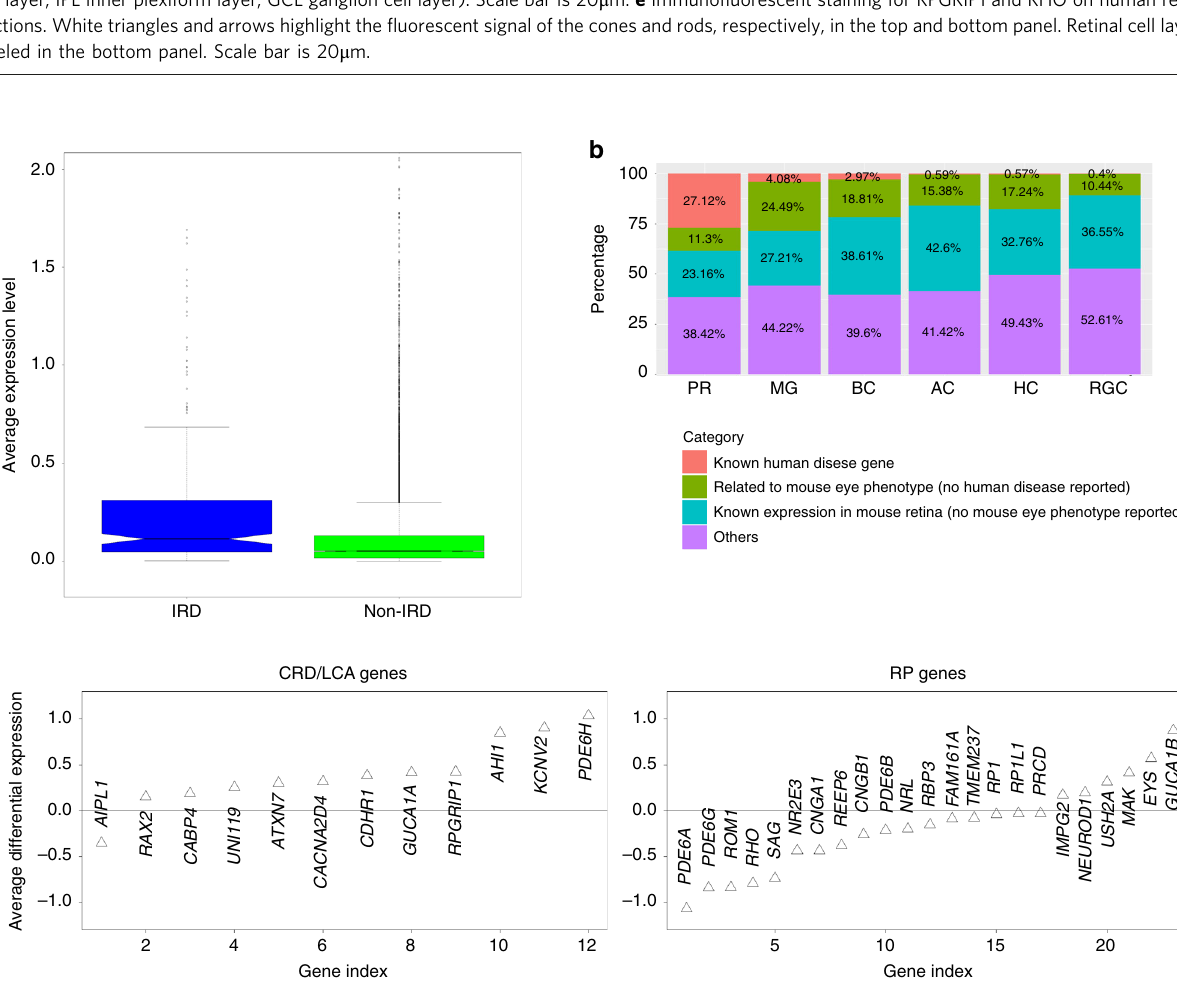
Fig. 5 Photoreceptor DEGs enrich human IRDs. a IRD genes generally show higher expression level than the rest of genes in the human retina. Expression values for each gene were normalized by cell total reads, multiplied by 10,000 and then log-transformed (natural logarithm), before averaging. In the box plots, bounds of the box spans from 25 to 75% percentile, center line represents median, and whiskers visualize 1.5 times inter-quartile range less than quartile 1 or 1.5 times inter-quartile range more than quartile 3 of all the data points. b Distribution of human retinal disease genes, mouse eye phenotype genes (but no human disease discovered), mouse retinal expressing genes (but no eye phenotype found) in DEGs of all cell types. c RP genes and CRD genes show different expression trend in rod and cone photoreceptors. The y -axis is representing the differential expression of each gene in cone cells compared with rod cells (cone expression level minus rod expression level). Expression values for each gene were normalized by cell total reads, multiplied by 10,000 and then log-transformed (natural logarithm), before averaging within cell types (rod,